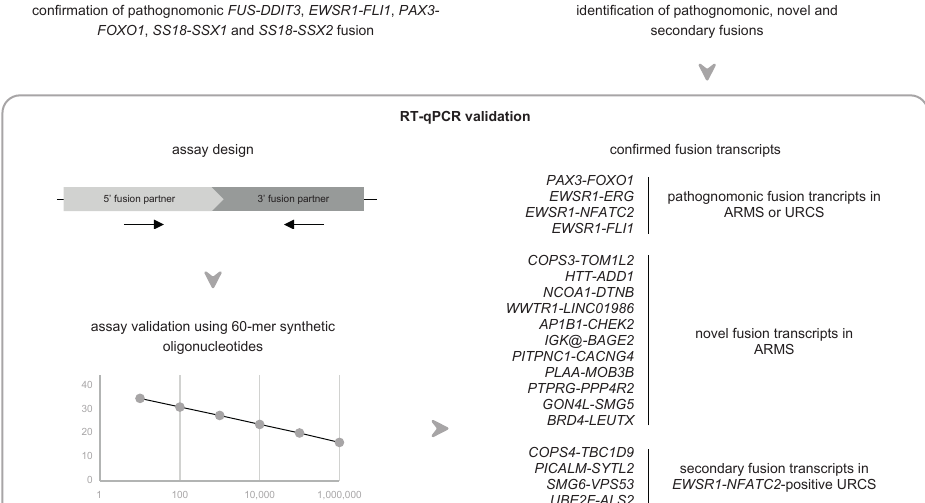
Figure 1. mRNA capture sequencing and RT-qPCR for the detection of pathognomonic, novel, and secondary fusion transcripts in FFPE sarcoma tissue. Cohort I, comprising six patients with a known pathognomonic fusion, is profiled using the TruSight RNA Pan-Cancer Panel. These data validated the mRNA capture sequencing analysis workflow for the identification of fusion transcripts. Subsequently, a second cohort of sarcomas that were designated fusion gene-negative by FISH analysis was analyzed using TruSeq RNA Exome sequencing. Multiple pathognomonic, novel, and secondary fusion transcripts were picked up and confirmed by